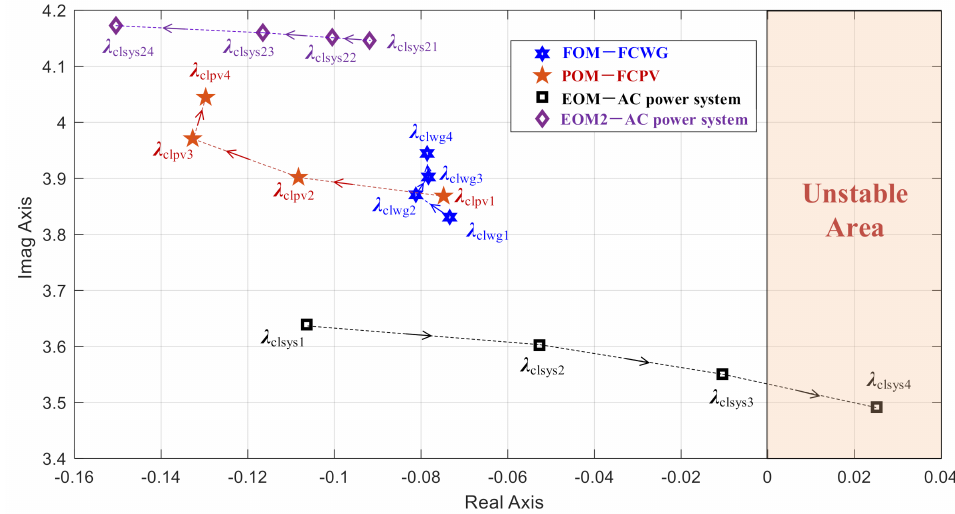
Figure 10. Modal shifts due to modal interaction in four